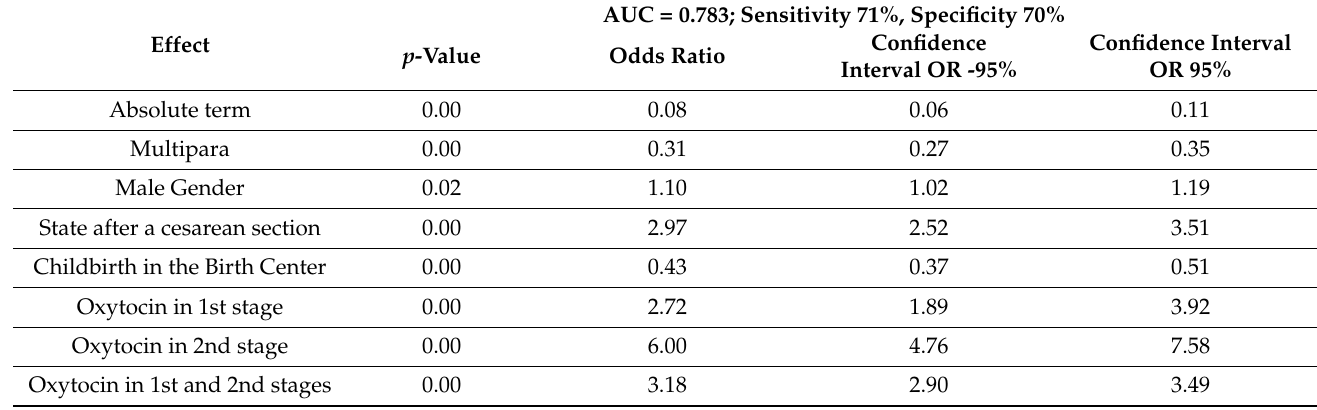
Table 5. Multivariate regression for